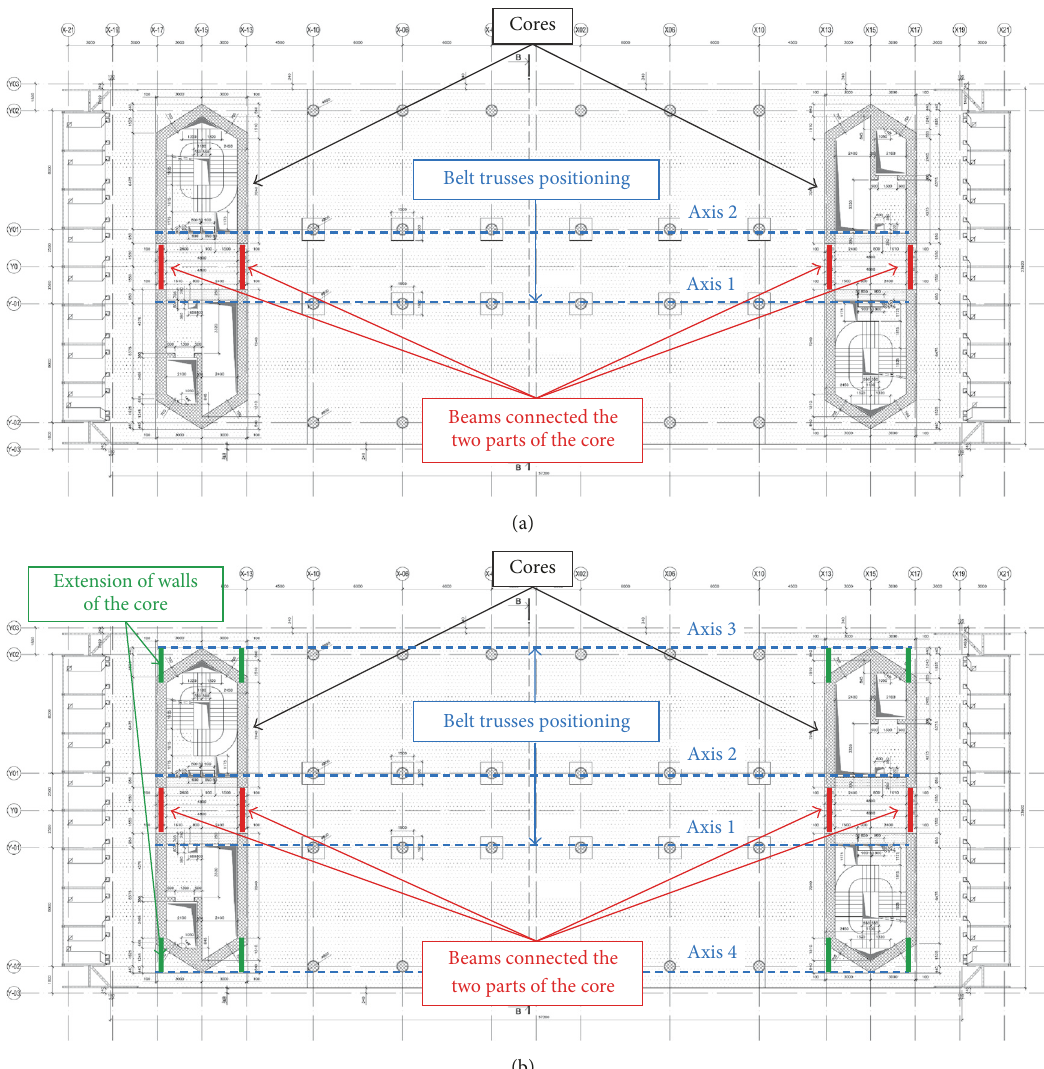
Figure 10: Schematic representation of the location of the built trusses in the top view: (a) two alignments and (b) four alignments.